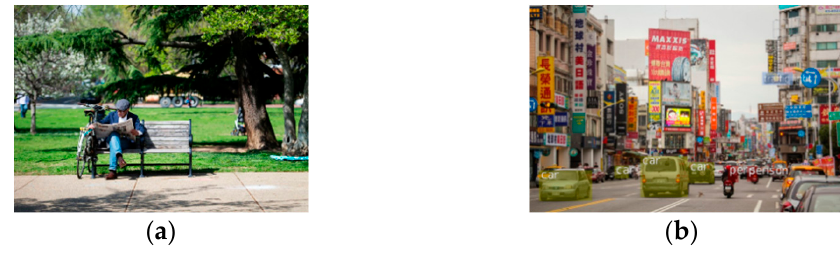
Figure 11. Results of preliminary identification: ( a ) first set; ( b ) second set.